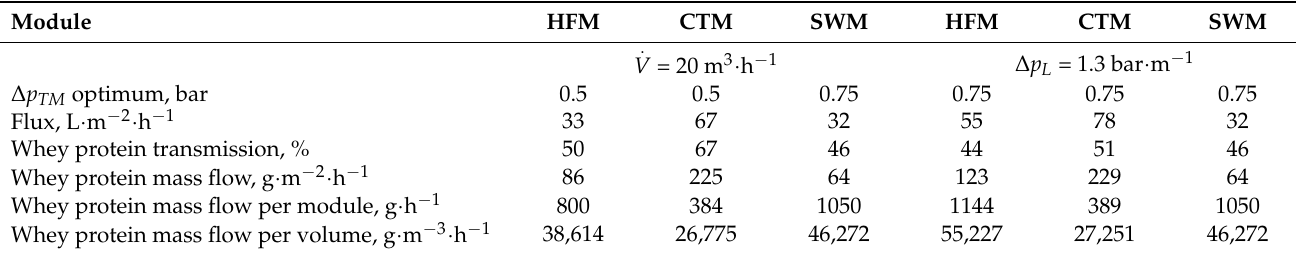
Table 5. Filtration performance of hollow fiber membranes (HFM), ceramic tubular membranes (CTM), and spiral wound membranes (SWM) for skim milk microfiltration at their ∆ p TM optima. Module HFM